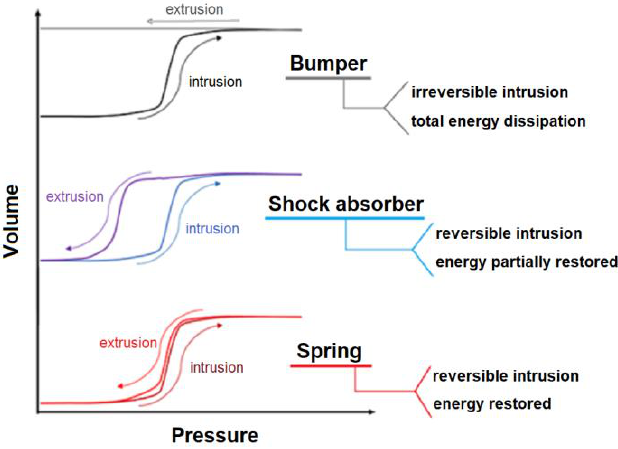
Figure 1. Schematic representation of three main behaviors of heterogeneous lyophobic systems.